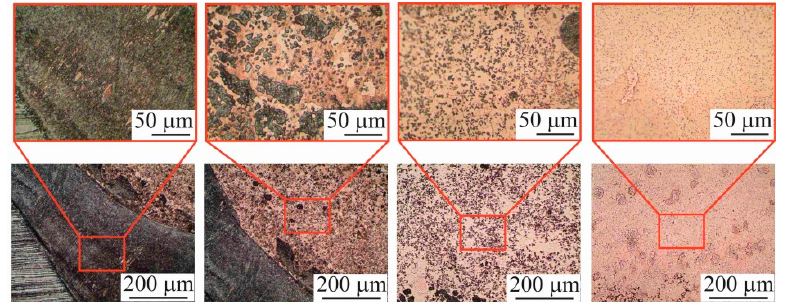
Figure 9. The microstructure of the C-type copper block in the transitional boundary.